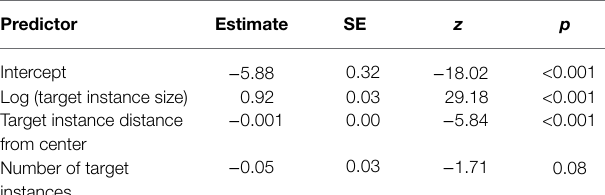
TABLE 2 | Multilevel logistic regression model predicting accuracy from target instance features, Experiment 1. Predictor